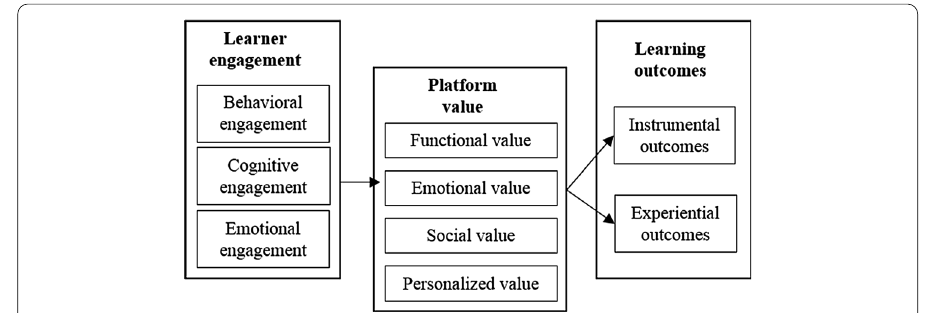
Fig. 2 Conceptual model of learner value co-creation